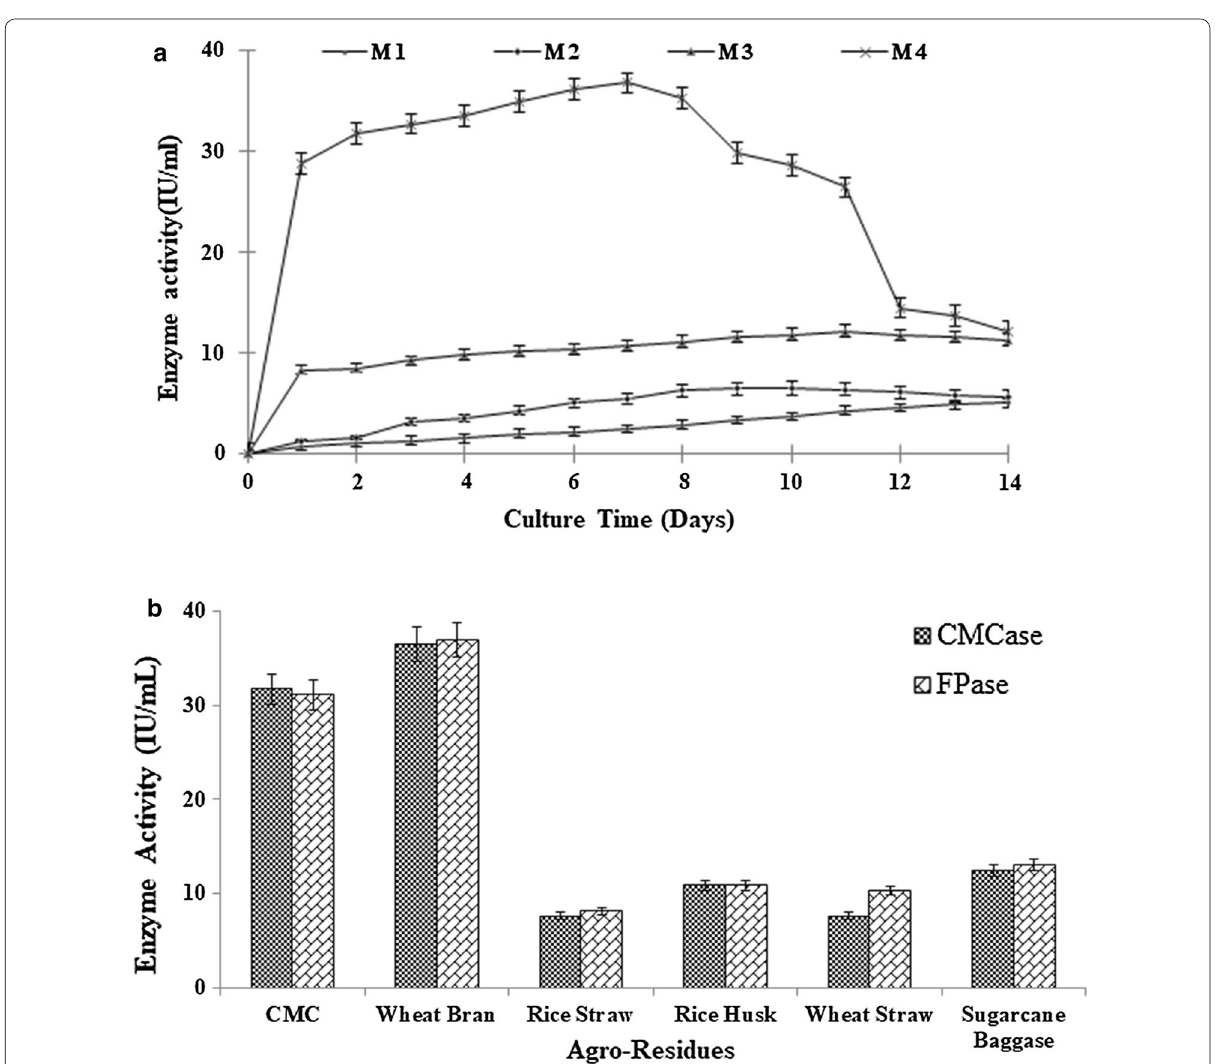
Fig. 1 Cellulase production using different media and agro-residues. a Cellulase production by Schizophyllum commune NAIMCC-F-03379 using different media (M1, M2, M3 and M4). b Selection of agro-residues for cellulase production by Schizophyllum commune NAIMCC-F-03379 in M4